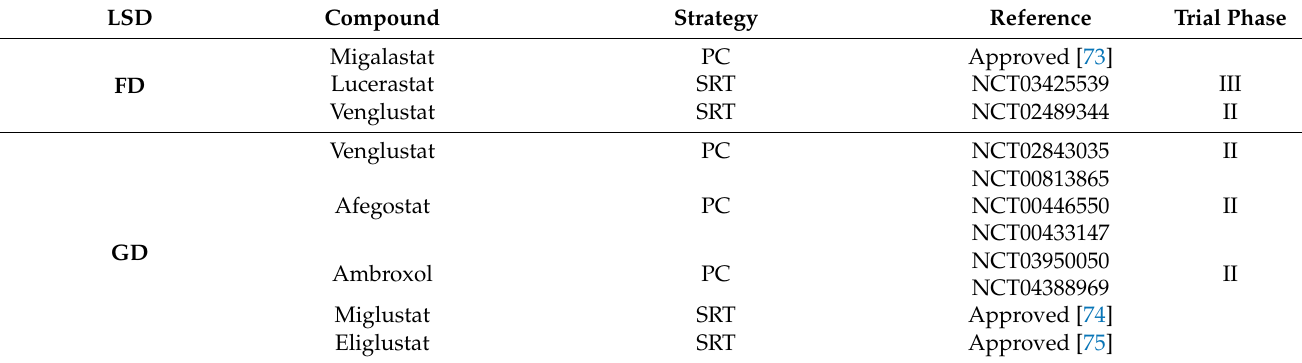
Table 4. Small molecules, approved of under clinical development, for the treatment of